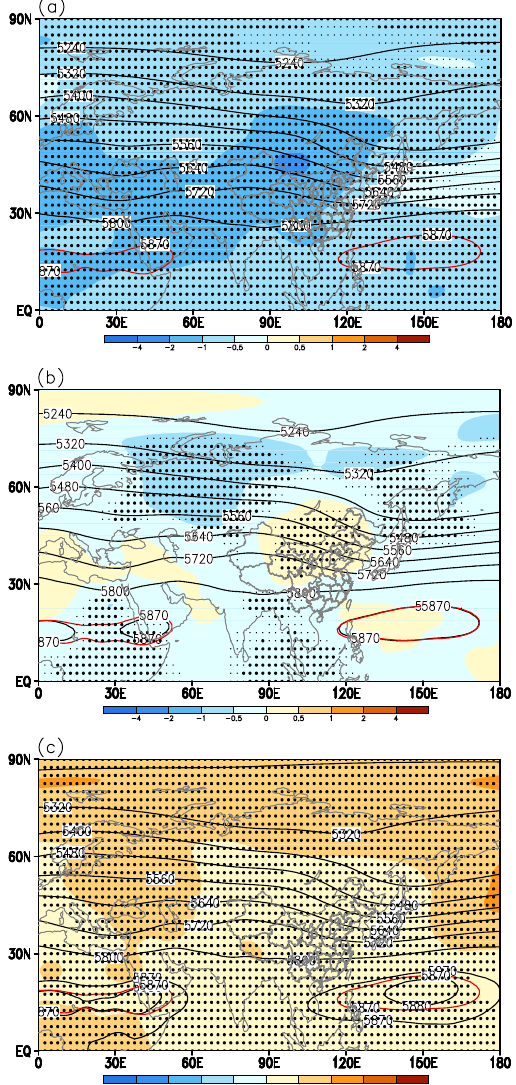
Figure 5. 500-hPa geopotential height field (black solid line, unit: gpm) and the composite anomaly field (shading, unit: gpm) at the stages of ( a ) 1961–1992, ( b ) 1993–2002 and ( c ) 2003–2020 over the Dongting Lake basin. The red solid line represents the climatology of 5870-gpm isoline from 1981 to 2010, and the black dots indicate the area with the values exceeding the confidence level at 95%.